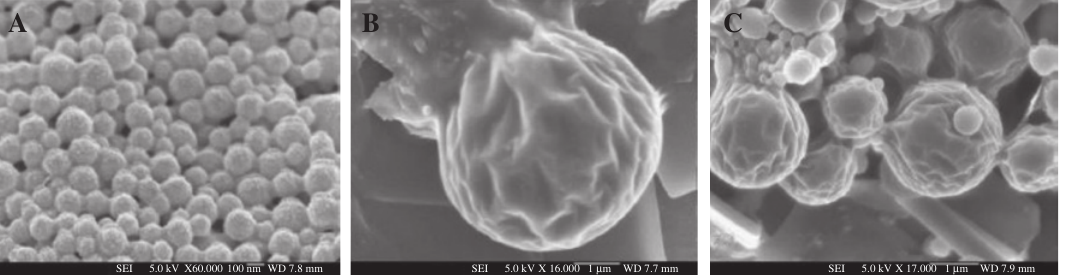
Figure 5: FESEM images of (A, B) docetaxel-loaded PLGA/poloxamer 188 NPs; (C) empty PLGA/poloxamer 188 NPs. Scale bar denotes 100 nm (A) and 1 μ m (B and C). Reprinted from Haiss et al.